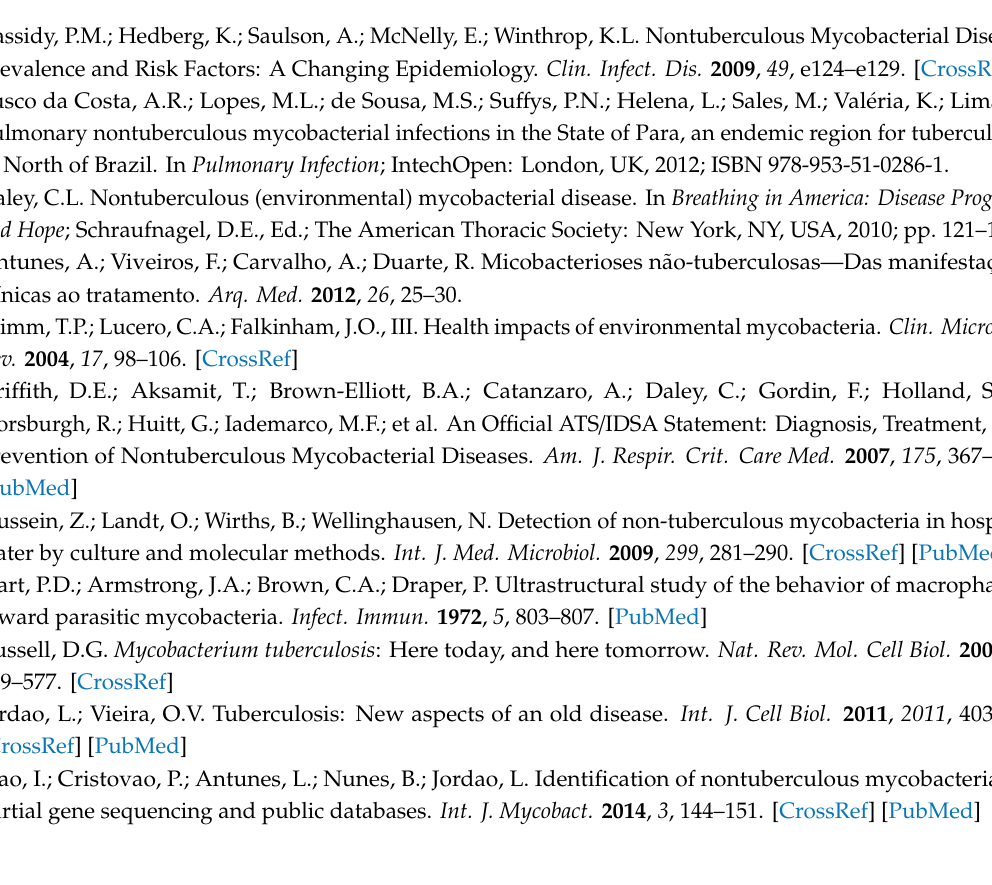
Table S1: Whole-genome sequencing statistics, Table S2: Repertoire of virulence genes in the five NTM genomes, Table S3: Global overview on the di ff erential accessory genome of same-species reference and clinical isolates, Table S4: List of genes likely associated with antibiotic resistance predicted in silico. Author Contributions: L.J. conceived, designed and analysed the phenotypic experiences, S.S. performed and analyzed the phenotypic experiences, I.J. performed antibiotic susceptibility and N.T.M. identification, V.B. and J.P.G. designed and performed W.G.S. analysis. All authors contributed for writing the